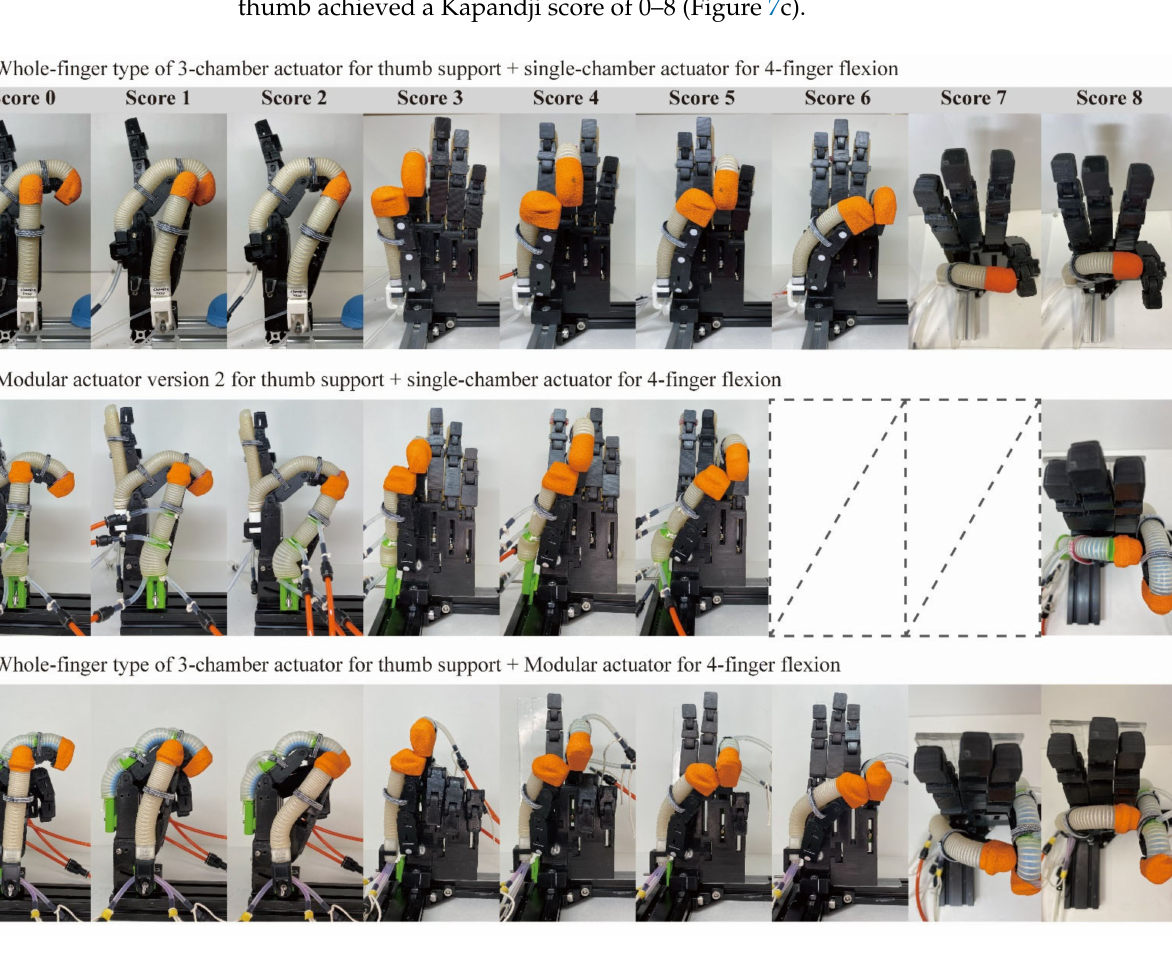
Figure 7. Kapandji test results of three actuator